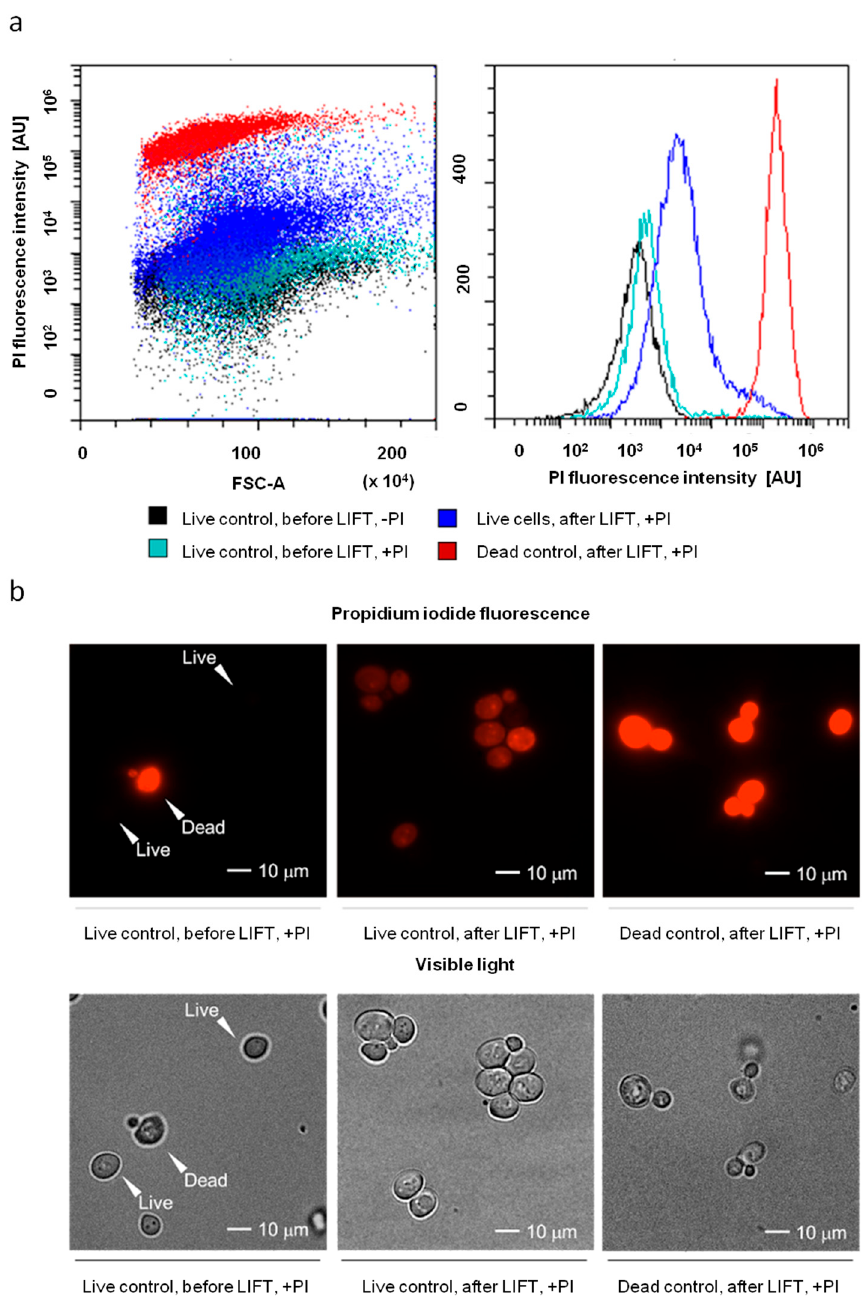
Figure 7. Emergence of weak cytosolic PI-staining after LIFT. ( a ) Flow cytometric analysis of PI-fluorescence ( b ) Fluorescent and DIC microscopy of cells.